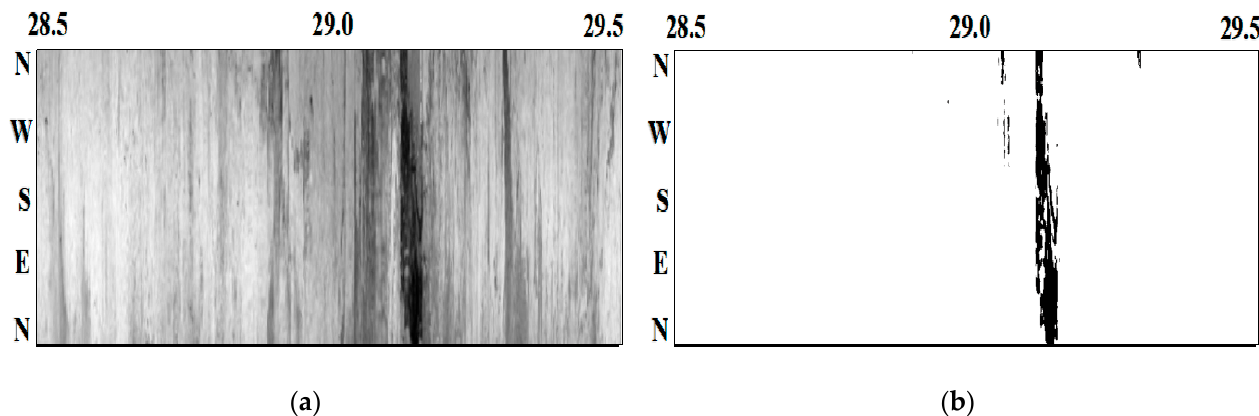
Figure 12. Reconstructed image and binary image. ( a ) Fusion image, ( b ) binarized image.